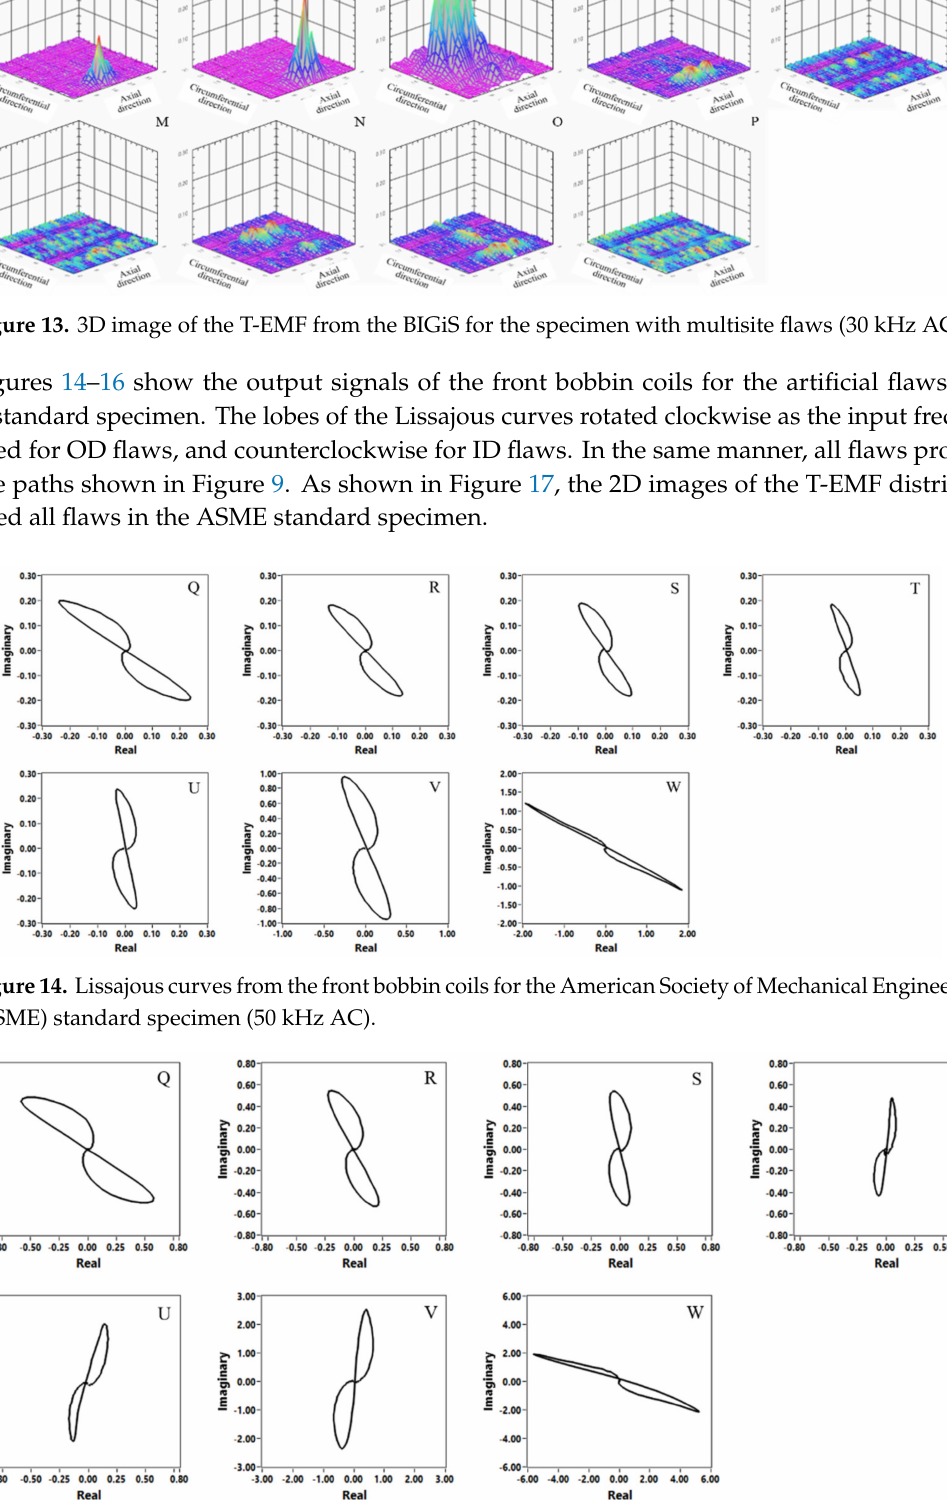
Figure 15. Lissajous curves from the front bobbin coils for the ASME standard specimen (100 kHz